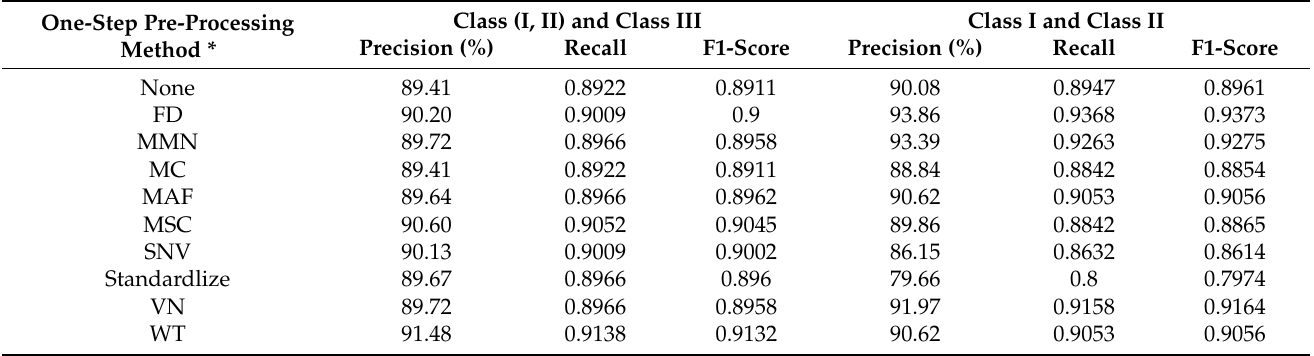
Table 2. Precision, Recall, and F1-score for prediction of spectral data with 1D-CNN based on different one-step pre-processing